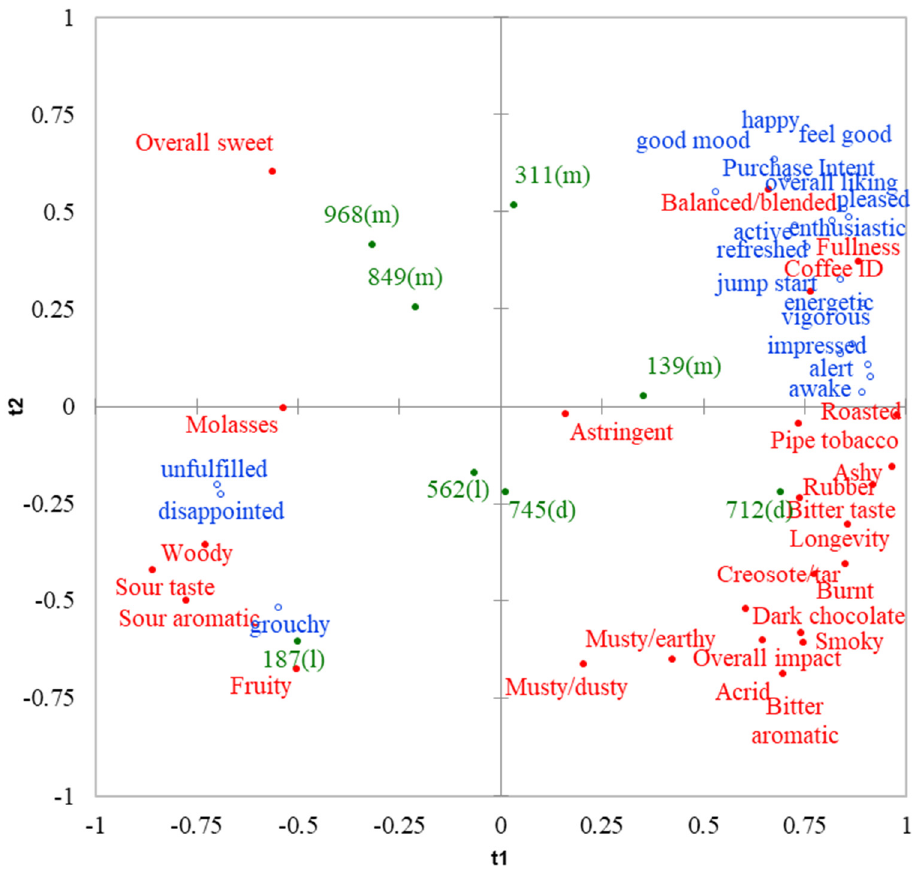
Figure 3. Partial least square regression map showing positioning of eight brewed black coffee samples in the sensory and emotion space. • = sensory attributes, o = overall liking/purchase intent/emotion terms, • = samples with roast level in parenthesis (l = light, m = medium and d = dark).